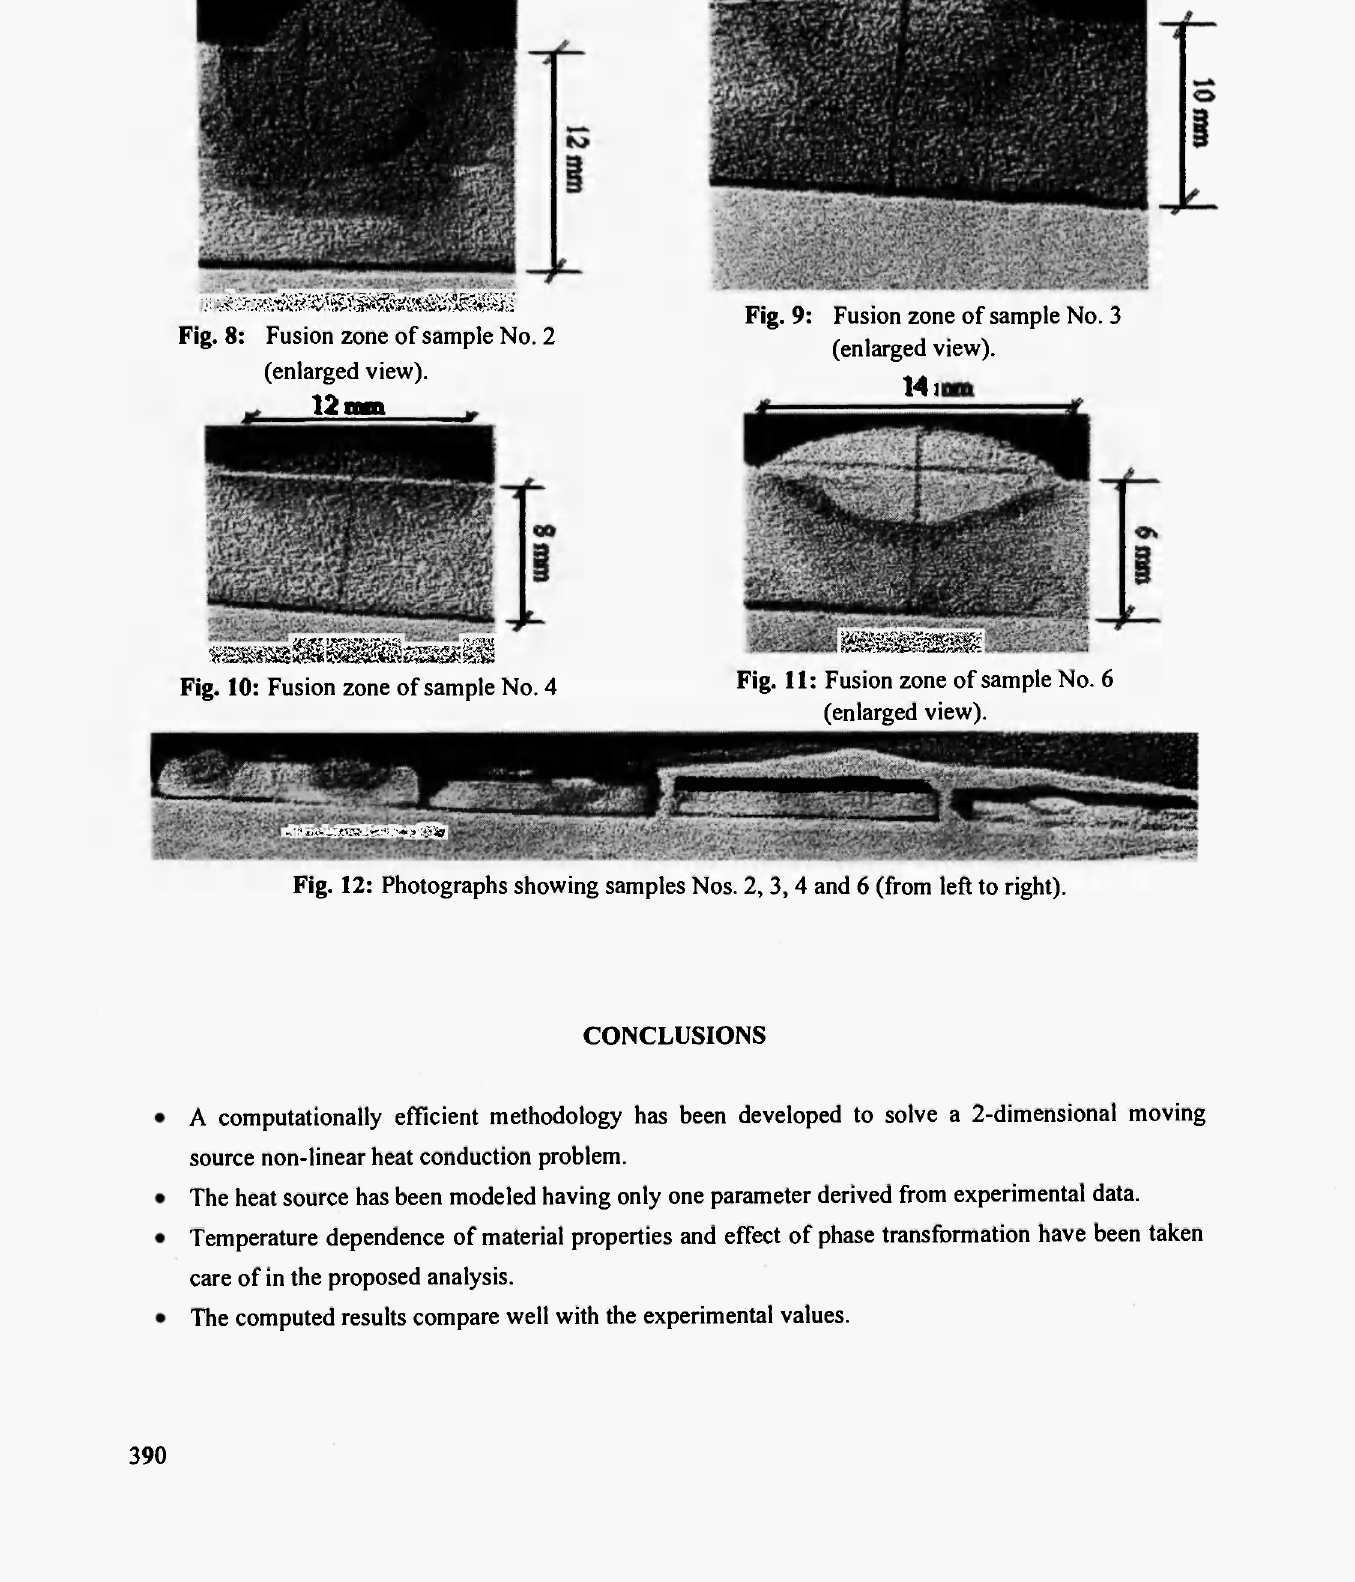
Fig. 9: Fusion zone of sample No. 3 (enlarged view).